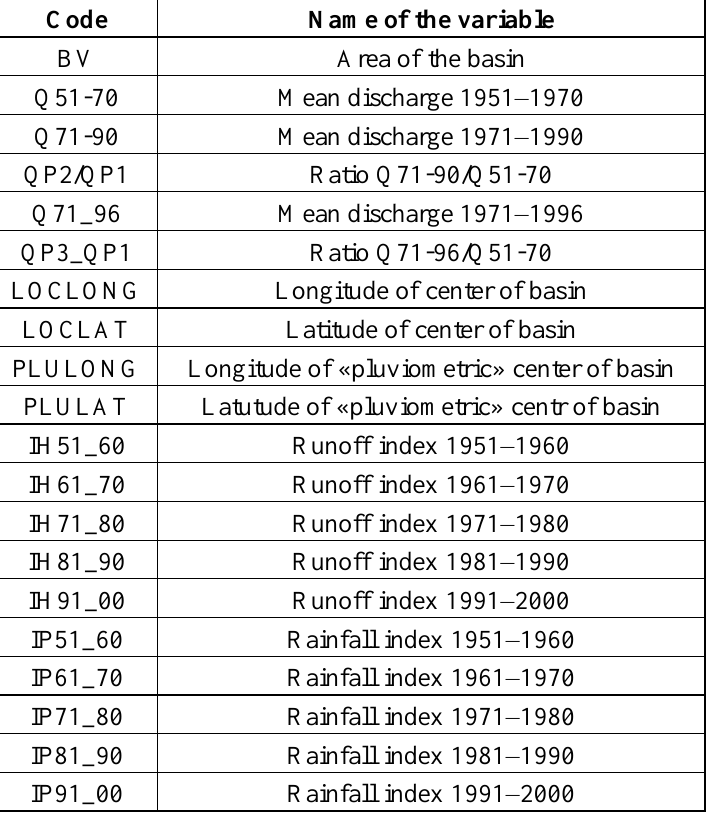
Table 9. List of variables used in the PCA.